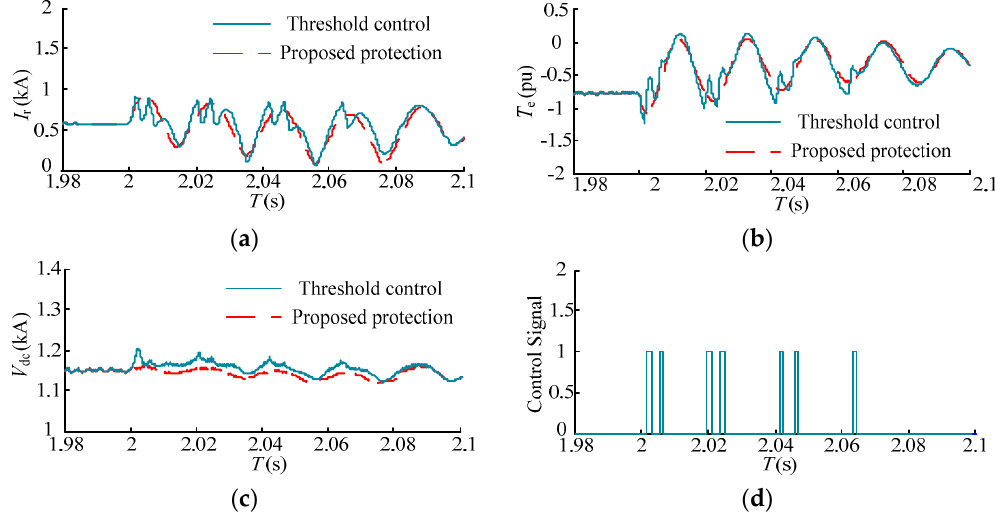
Figure 18. Comparisons between proposed protection and threshold control under a voltage sag of 0.6. ( a ) Rotor current; ( b ) electromagnetic torque; ( c ) DC-link bus voltage; and ( d ) the control signal of rotor braking resistor.